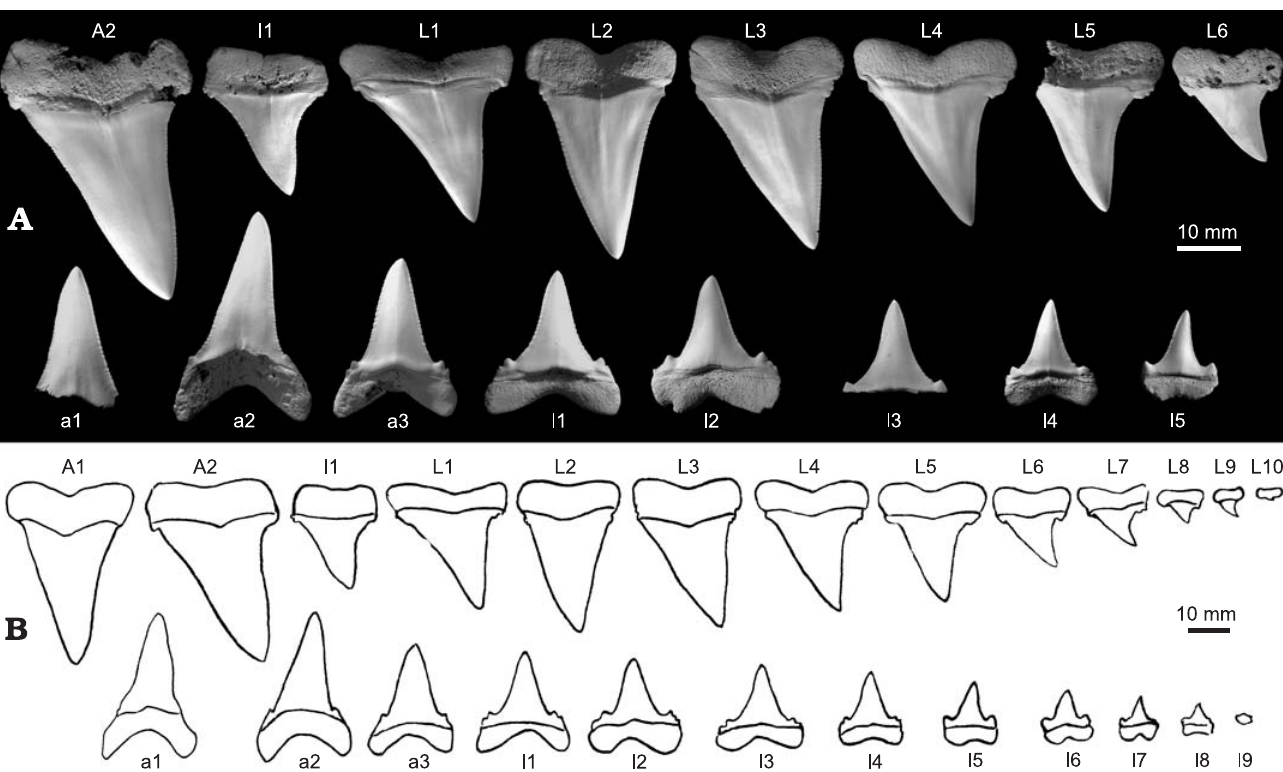
Fig. 12. Reconstructed left upper and lower tooth rows of the mackerel shark Carcharomodus escheri (Agassiz, 1843), in lingual view. A . Reconstruction based on preserved teeth. B . Drawing of the completely reconstructed dentition based on preserved teeth and comparisons with living lamnid